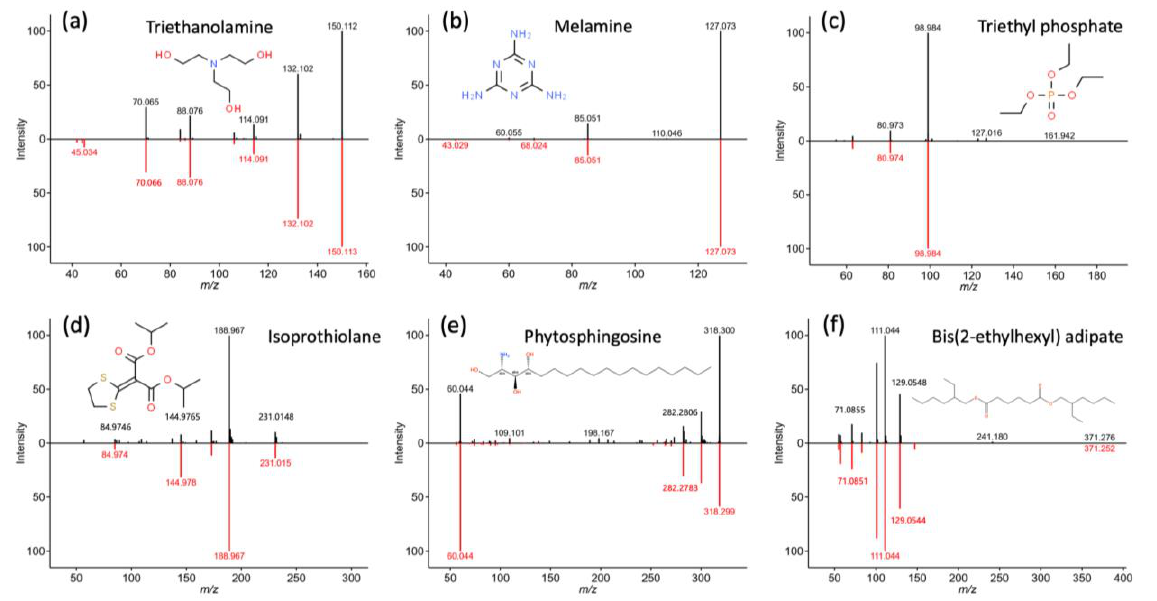
Figure 1. Mirror plots of the acquired MS/MS spectra (black) of six representative compounds against reference spectra (red) in compiled libraries, as detailed in Section 2.4. ( a ) Triethanolamine; ( b ) Melamine; ( c ) Triethyl phosphate; ( d ) Isoprothiolane; ( e ) Phytosphingosine; ( f ) Bis(2-ethylhexyl) adipate Table 2. Non-volatile substances tentatively identified in plant fiber/plastic composites.